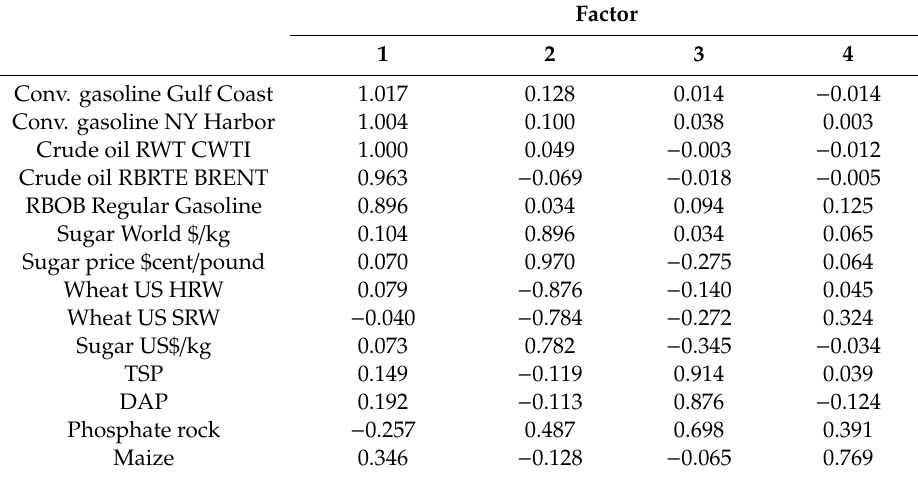
Table 7. Results of the factor analysis.